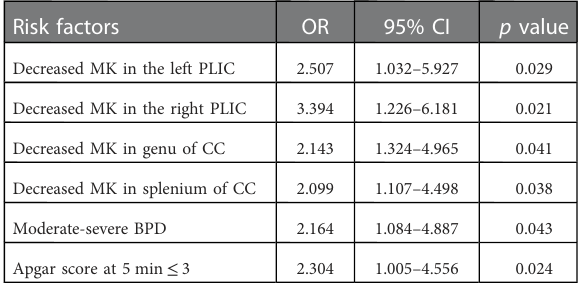
TABLE 4 Multivariate analysis for risk factors of neurodevelopmental impairments in EPI with severe